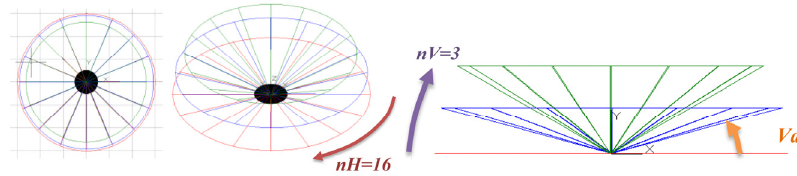
Figure 3. An example of definition of RGB-D axis directions for each position.